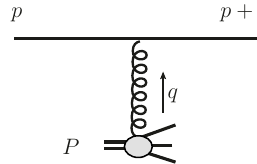
Figure 1 . Parton-nucleon scattering amplitude from which the potential (2.1) is